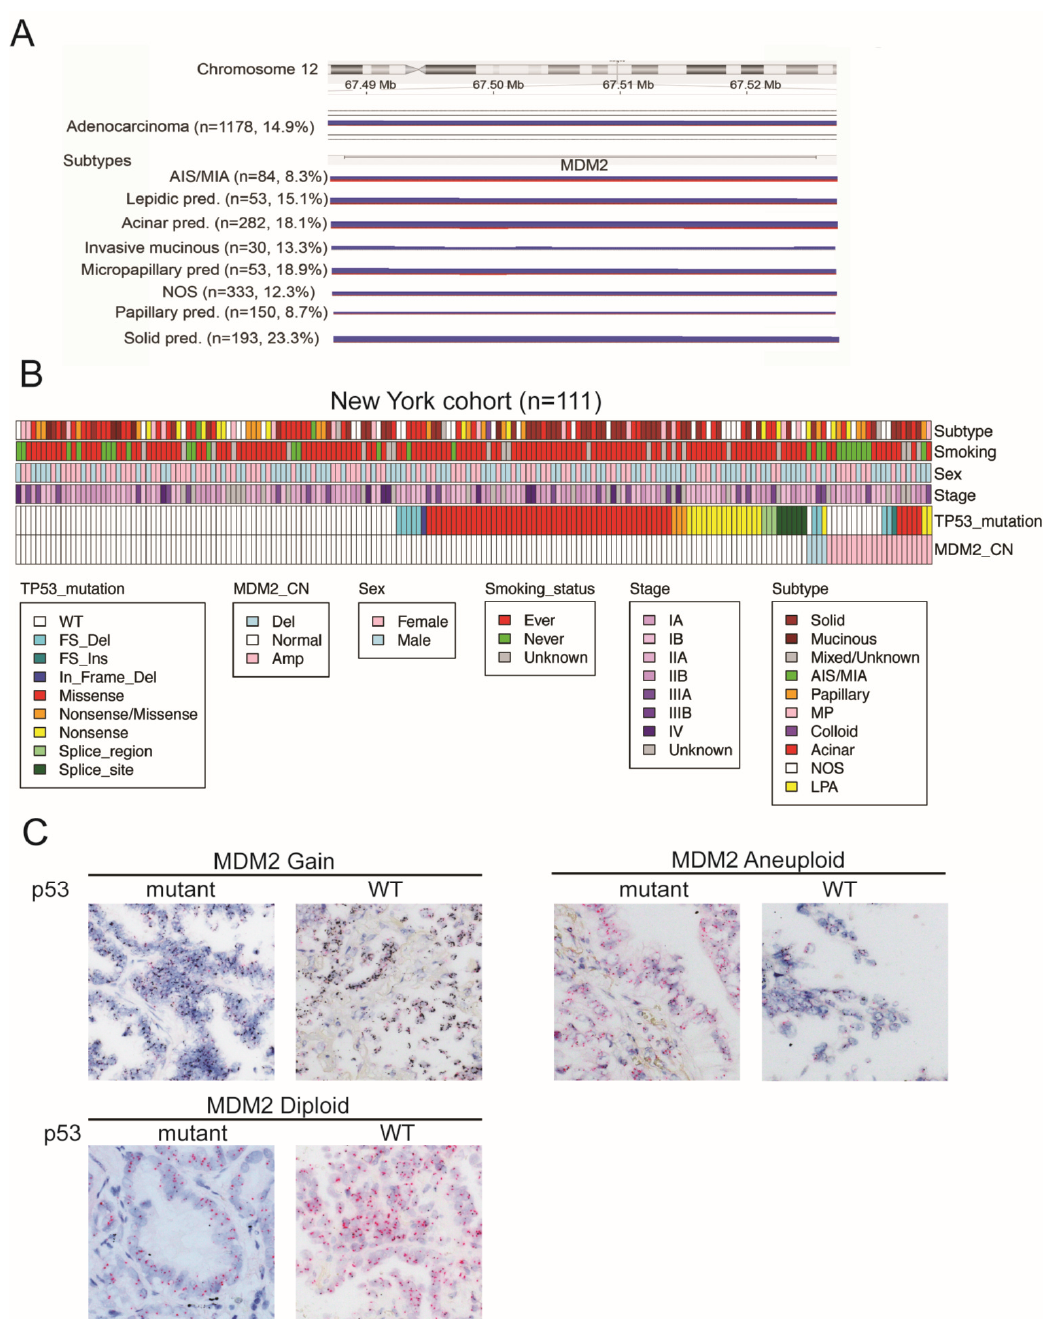
Figure 1. MDM2 genomic amplification and p53 mutation contribute to heterogeneity in lung adenocarcinoma. ( A ) Composite analysis of SNP array data from n = 1178 LUAD patients showing amplification (blue bars) or deletion (red bars) at MDM2 chromosome locus 12q15. Width of blue and red bars indicated the percent of samples in that group displaying MDM2 amplification in SNP array. Percent of samples with MDM2 amplification for total and each subtype is annotated on the left. ( B ) Heatmap showing distribution of MDM2 copy number (CN) and p53 mutation status for n = 111 LUAD patients from New York cohort. MDM2 CN was determined by CISH/FISH analysis. Subtype, smoking status, sex and stage for each patient is shown in top rows. ( C ) Representative images for CISH staining showing MDM2 amplification in MDM2 gain, aneuploid and diploid condition with p53 mutant or WT for each case. MDM2 is visualized as black signal and CHR12 is visualized as red signal. The magnification of the figure is 10 ×